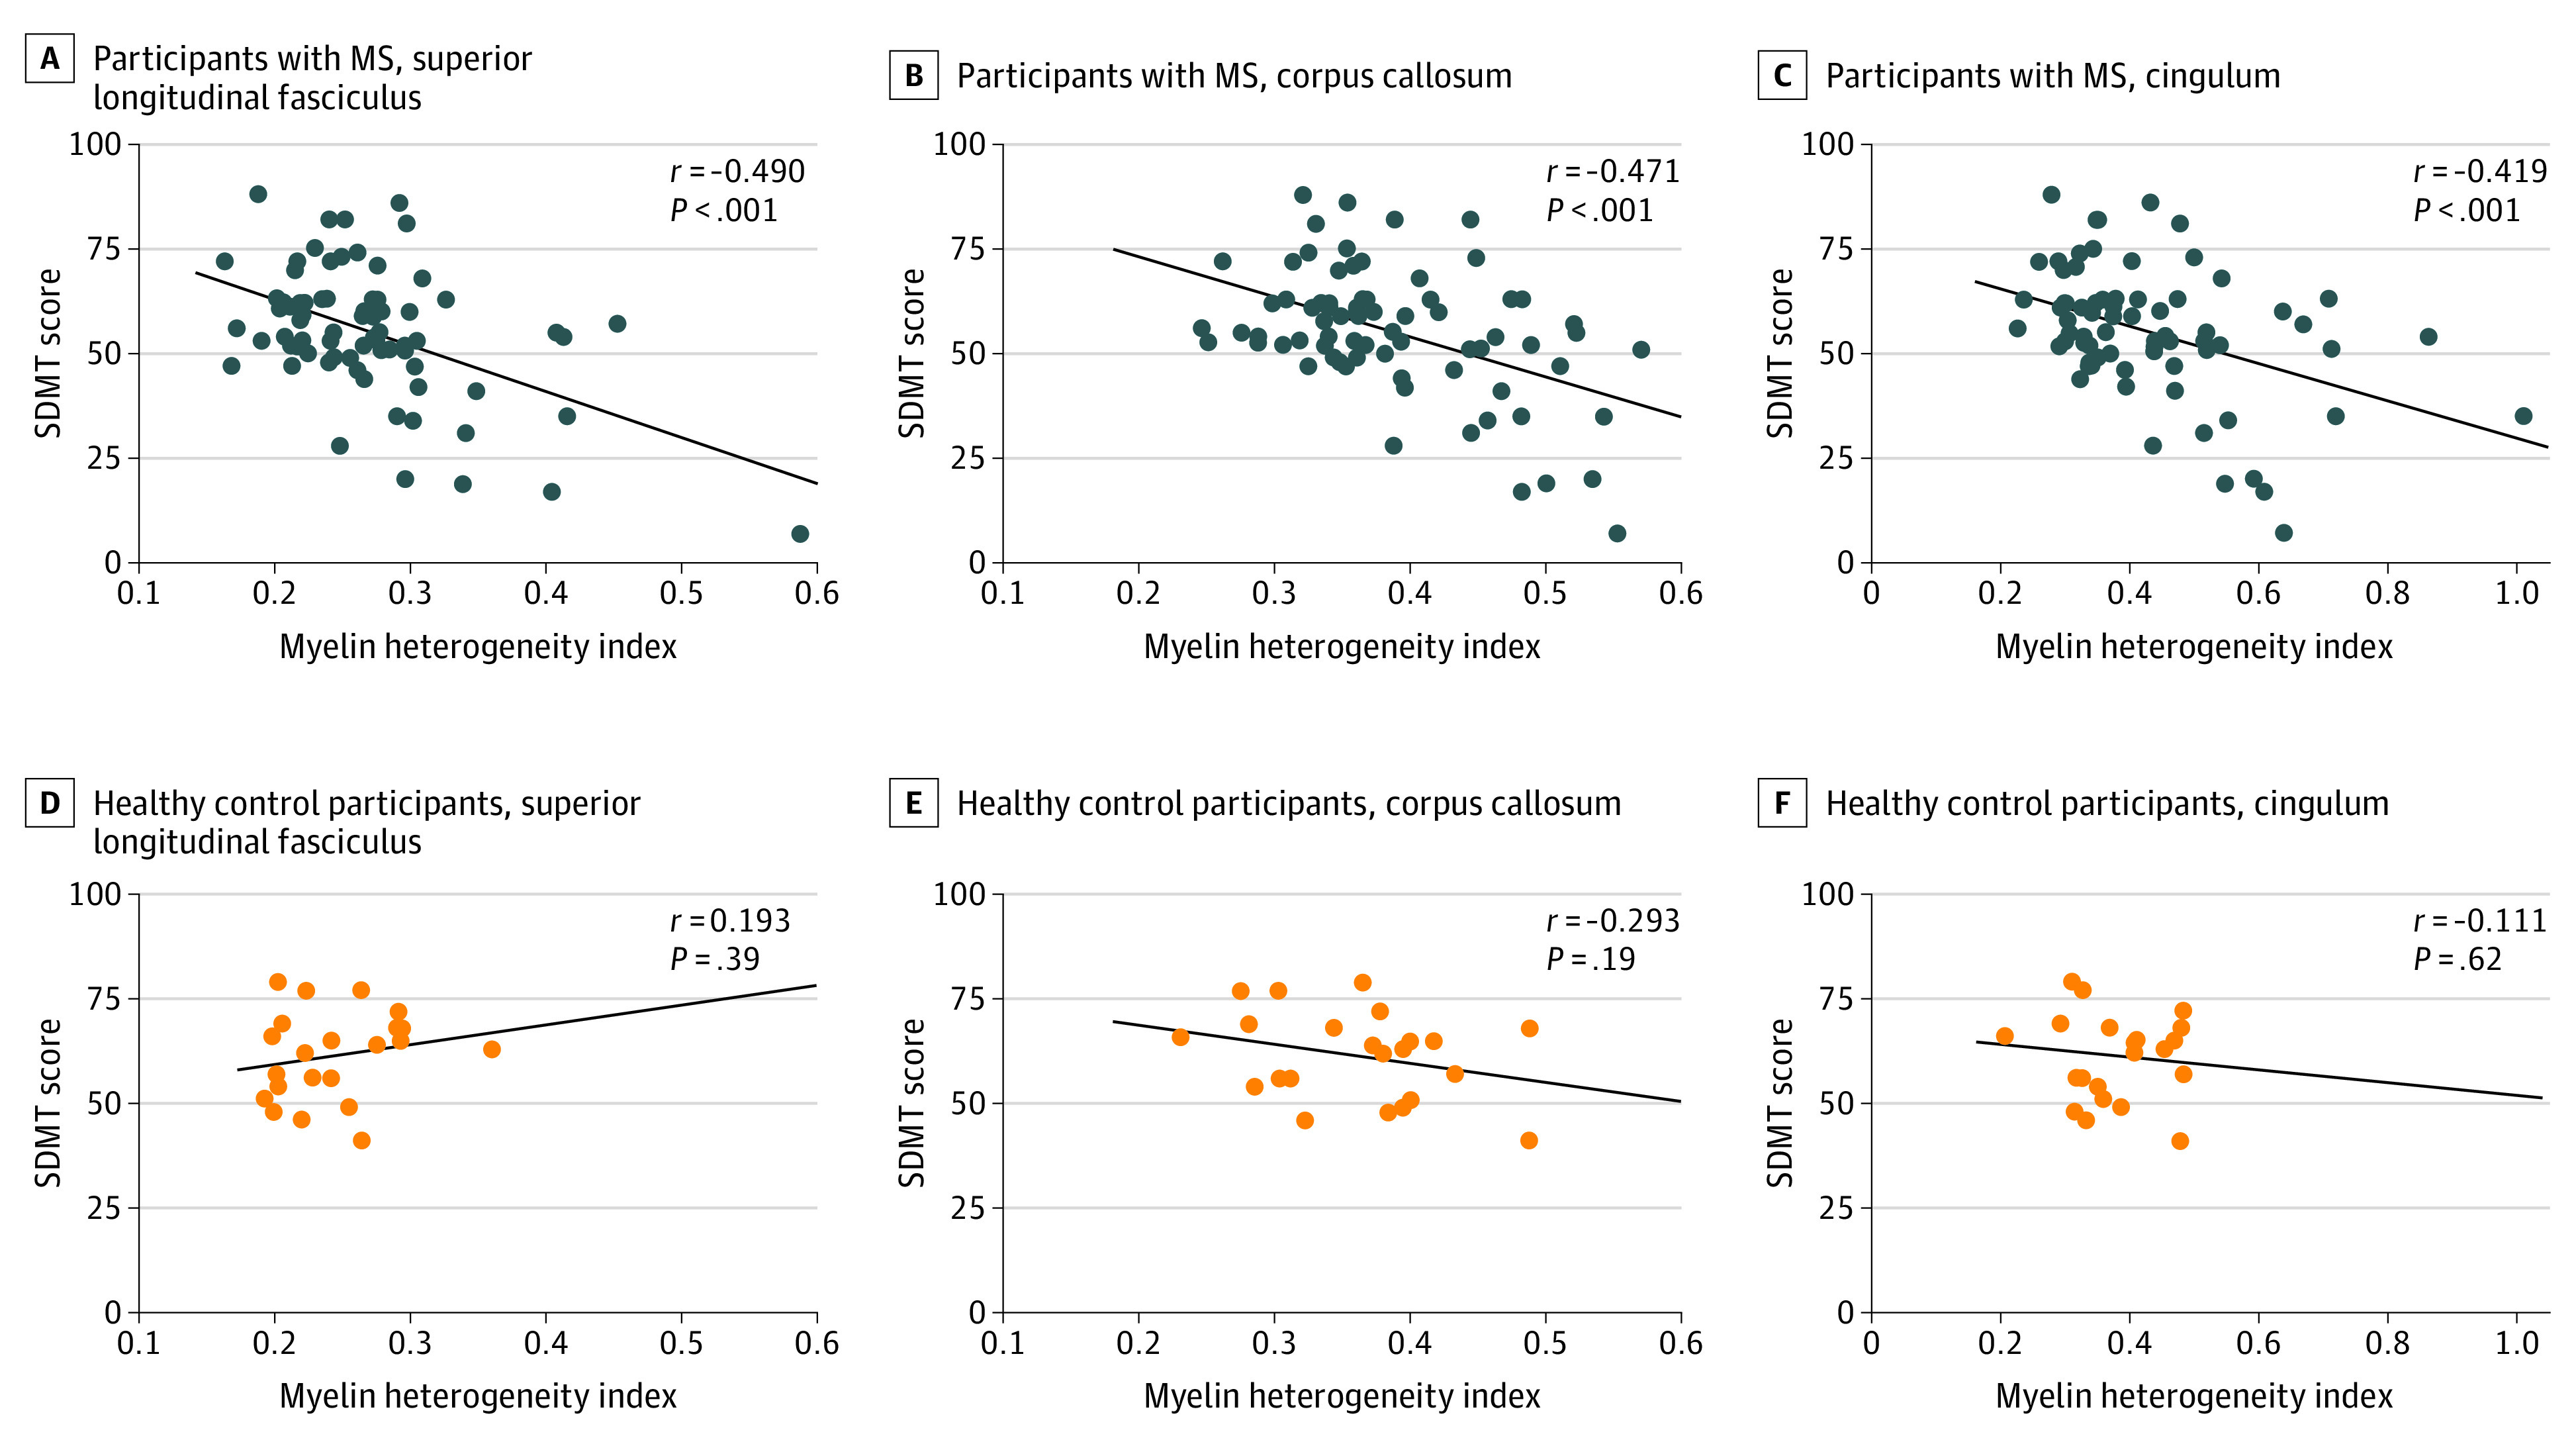
Correlations Between Symbol Digit Modalities Test (SDMT) Performance and Myelin Heterogeneity IndexCorrelations between the myelin heterogeneity index in normal-appearing white matter and SDMT scores are shown for participants with multiple sclerosis (MS) and controls in 3 regions of interest. Lines denote lines of best fit.